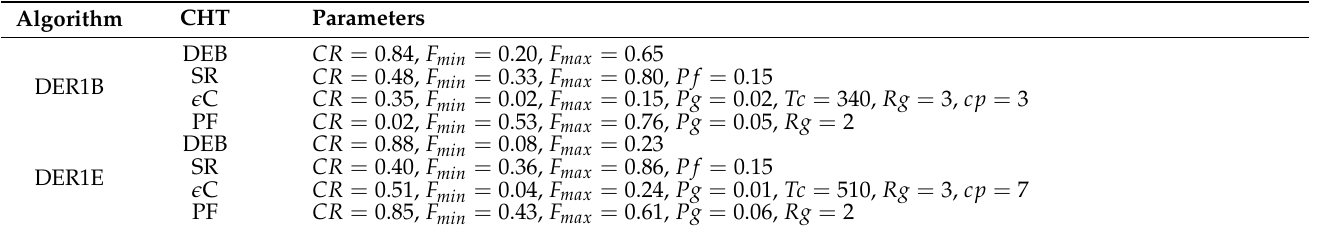
Table A6. Tuned parameters by irace program for study case 3: Eight-bar linkage